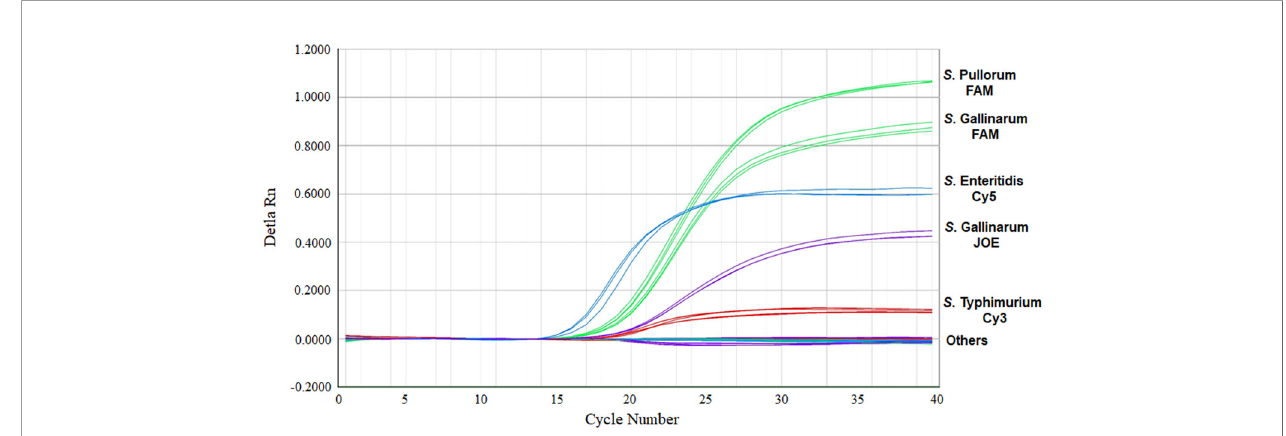
FIGURE 2 | Speci fi city of the multiplex real-time PCR for the detection and differentiation of S . Pullorum, S . Gallinarum, S . Enteritidis, and S. Typhimurium. Others: None of these four Salmonella serovars